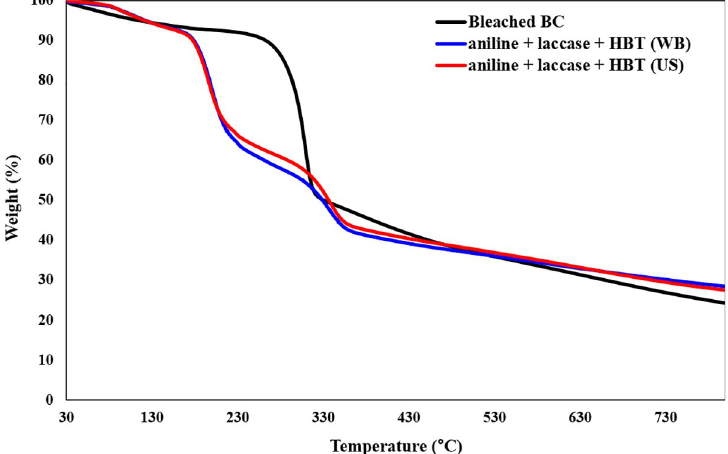
Fig 6. TGA analysis of polyaniline polymerized by laccase: (a) untreated BC; (b) bleached BC; (c) aniline + laccase + HBT (WB); (d) aniline + laccase + HBT (US).